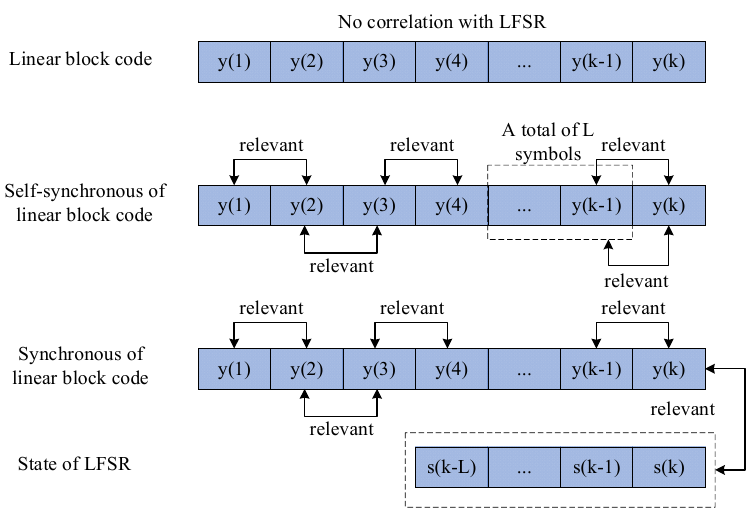
Figure 3. Symbol correlation analysis of linear block code scrambling.